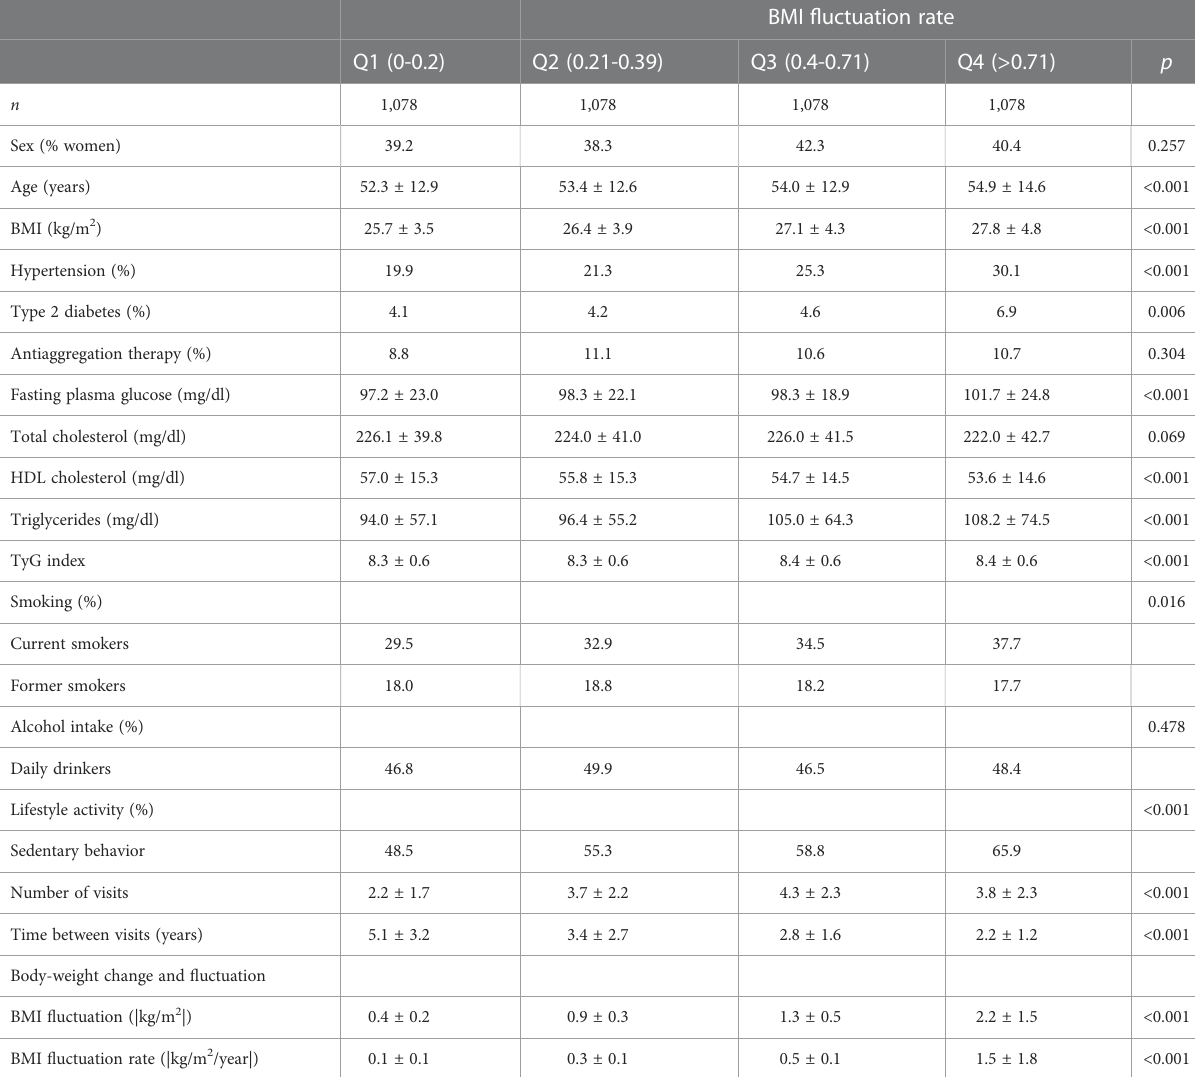
TABLE 1B Baseline demographics and risk factor pro fi les according to quartiles of body mass index (BMI) fl uctuation rate (|(kg/m 2 )/year|) of 4,312 participants drawn from the VMCUN clinical cohort between 1997 and 2015 in